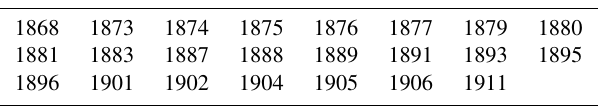
Table B3. Years below the median of SPEI (drier conditions) during the years 1865–1911.